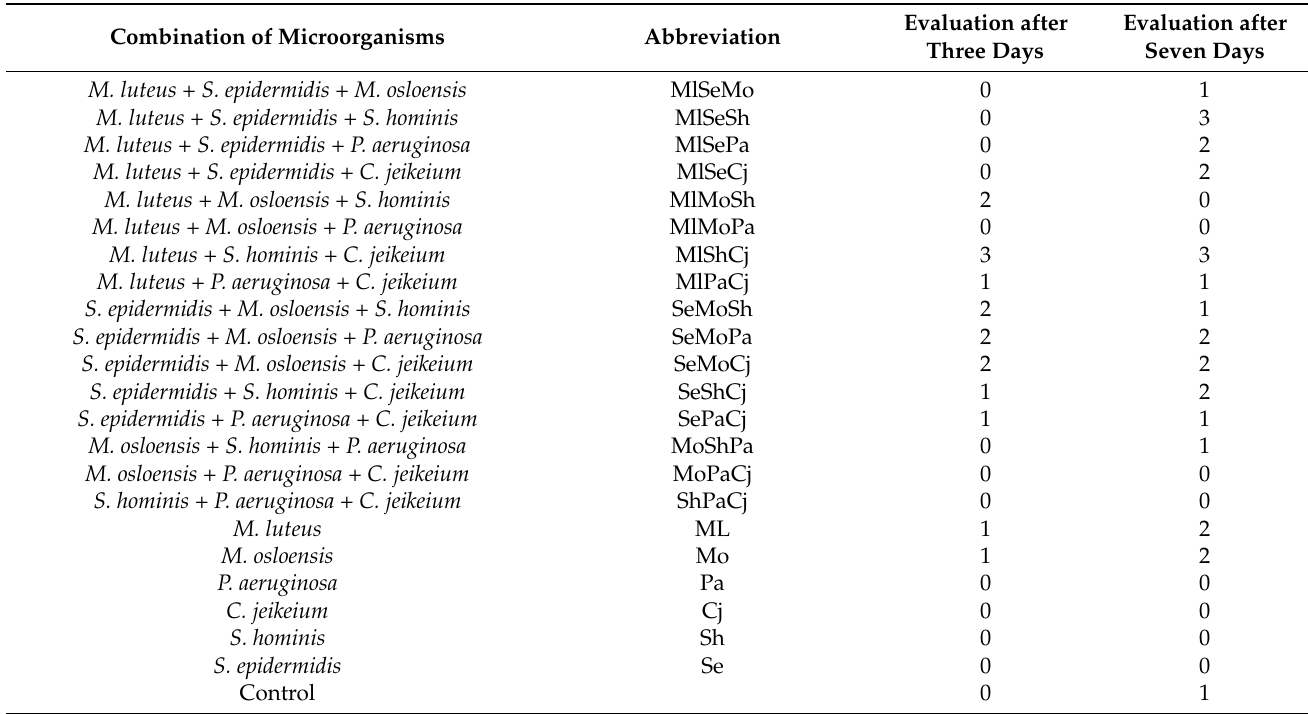
Table 3. Overview of the bacterial combinations used for the tests ( n = 5). Intensities ranged from 0 (no odour) to 3 (intensive